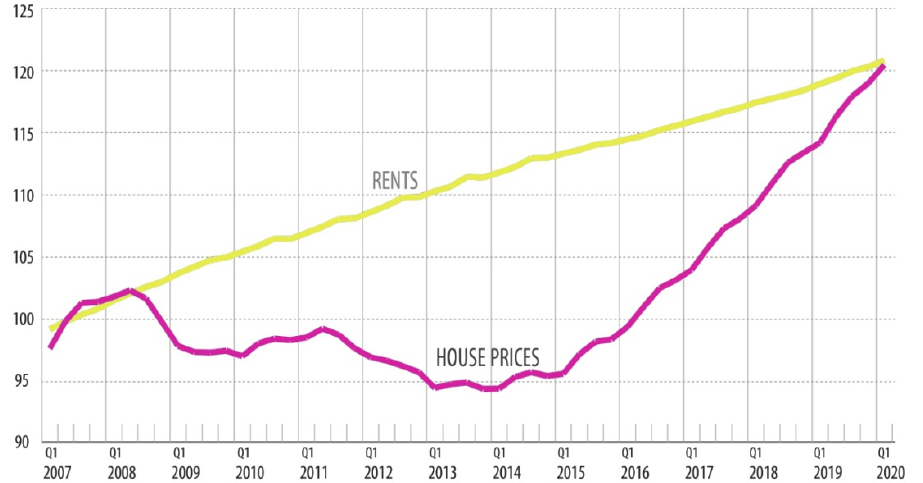
Figure 2. Evolution of rent and housing values indices in Portugal (2007 to 2020) (2007 = 100) Source: [36].